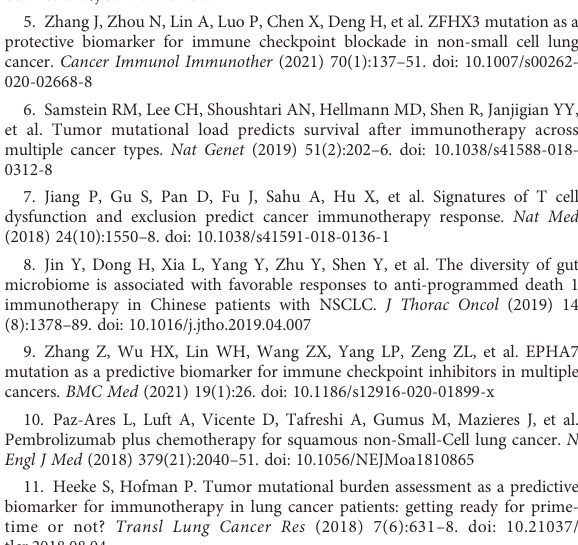
SUPPLEMENTARY FIGURE 6 Association between SMO mutation and IGR1R/AKT pathway. (A, B) GSEA analysis of IGF1R related signaling activity between the SMO -mutated and the wild-type tumors. (C, D) Western blot analysis of different SMO mutations on the IGF1R/AKT pathway activity. SUPPLEMENTARY TABLE 8 Signi fi cant pathways detected by gene set enrichment analysis.